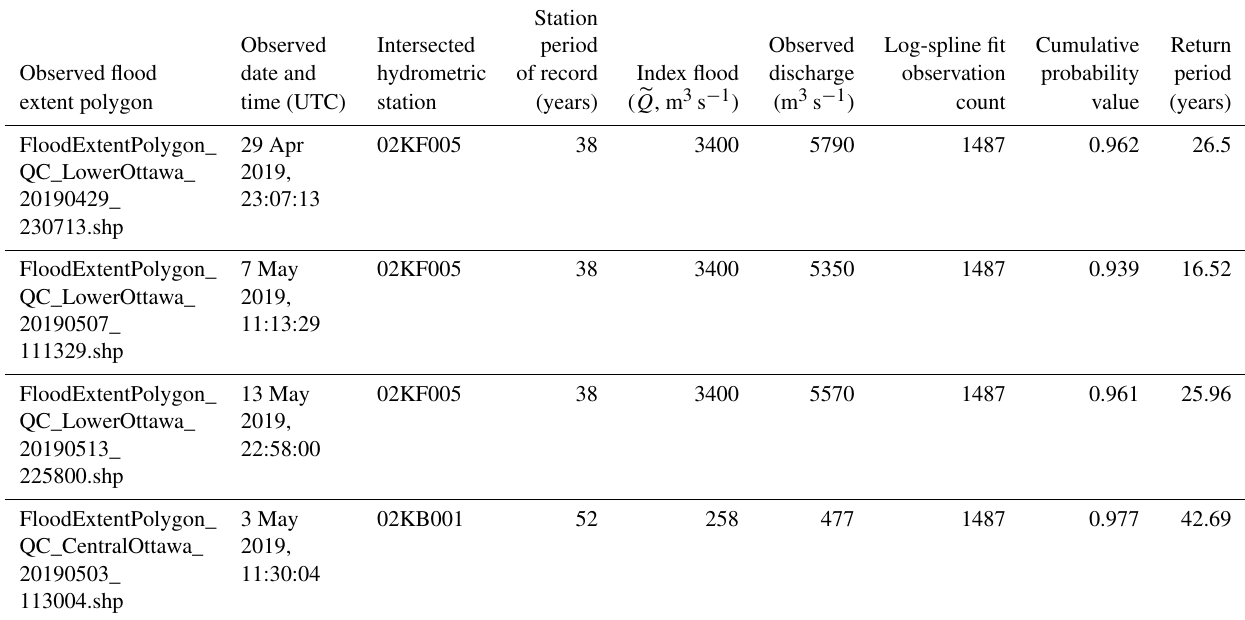
Table 3. Simulated Flood Generation – Ottawa River Watershed. Station Observed Intersected period Observed Log-spline fit Cumulative Return Observed flood date and hydrometric of record Index flood observation